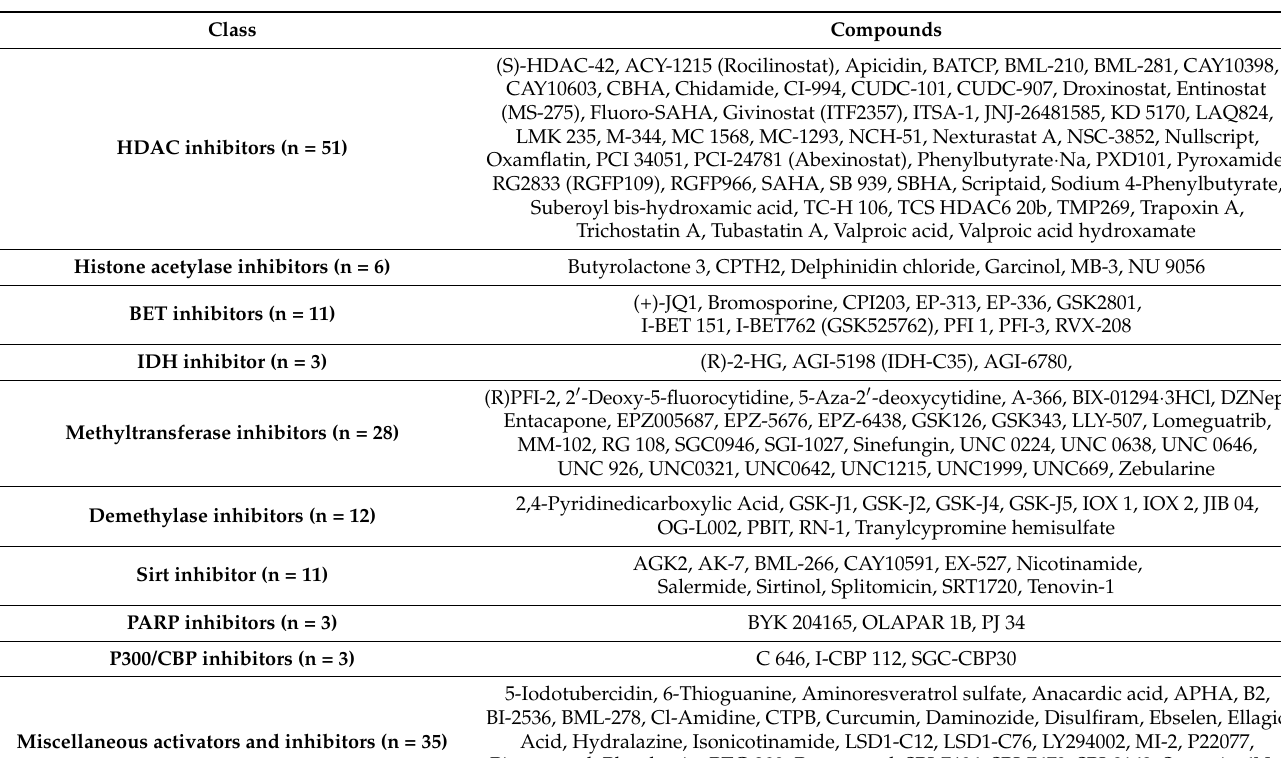
Table 1. Compound list of the Epigenetics modifier